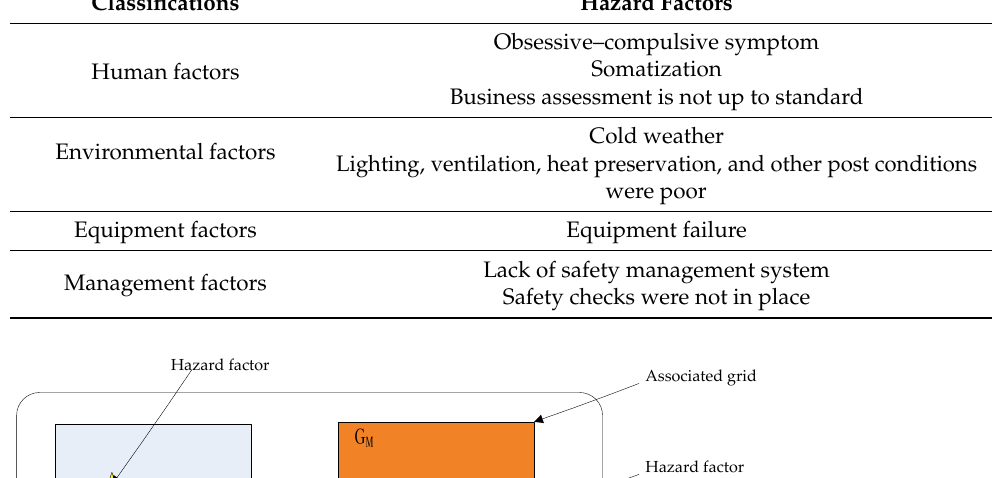
Table 2. Hazard factors of grid G H .